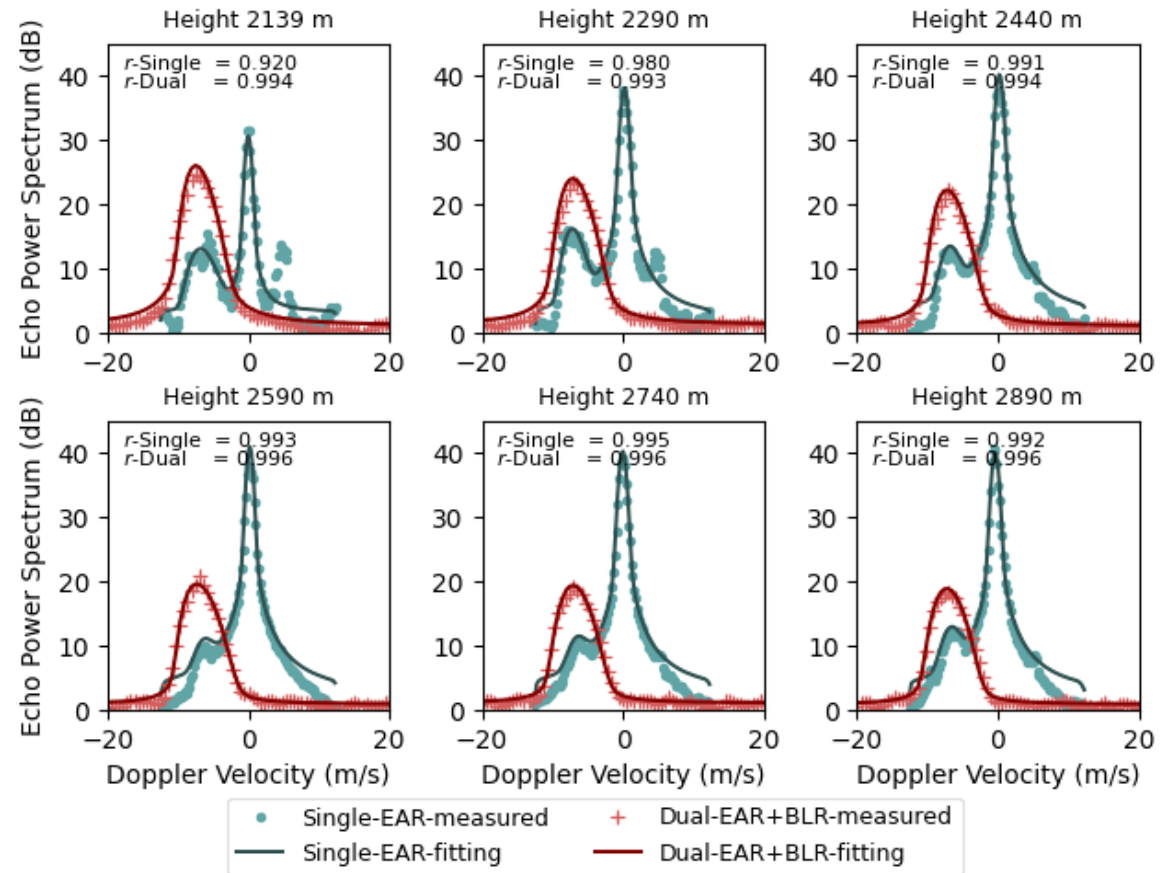
Figure 3. Plots of measured and fitted spectra at heights from 2139 m to 2890 m ASL, at 14.08 local time on April 23, 2004. Circles are the single measured-spectrum, blue lines are single fitted-spectrum, plus signs are dual measured-spectrum, and red lines are dual